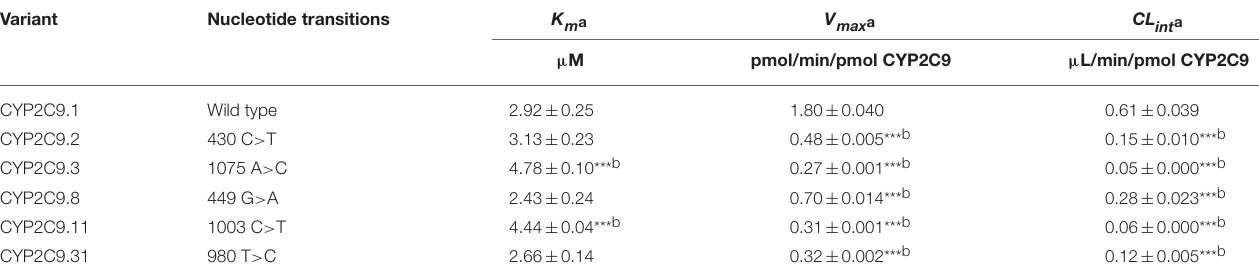
TABLE 1 | In vitro kinetic parameters for S-warfarin 7-hydroxylation by COS-7 cell-expressed CYP2C9.1, CYP2C9.2, CYP2C9.3, CYP2C9.8, CYP2C9.11, and CYP2C9.31.